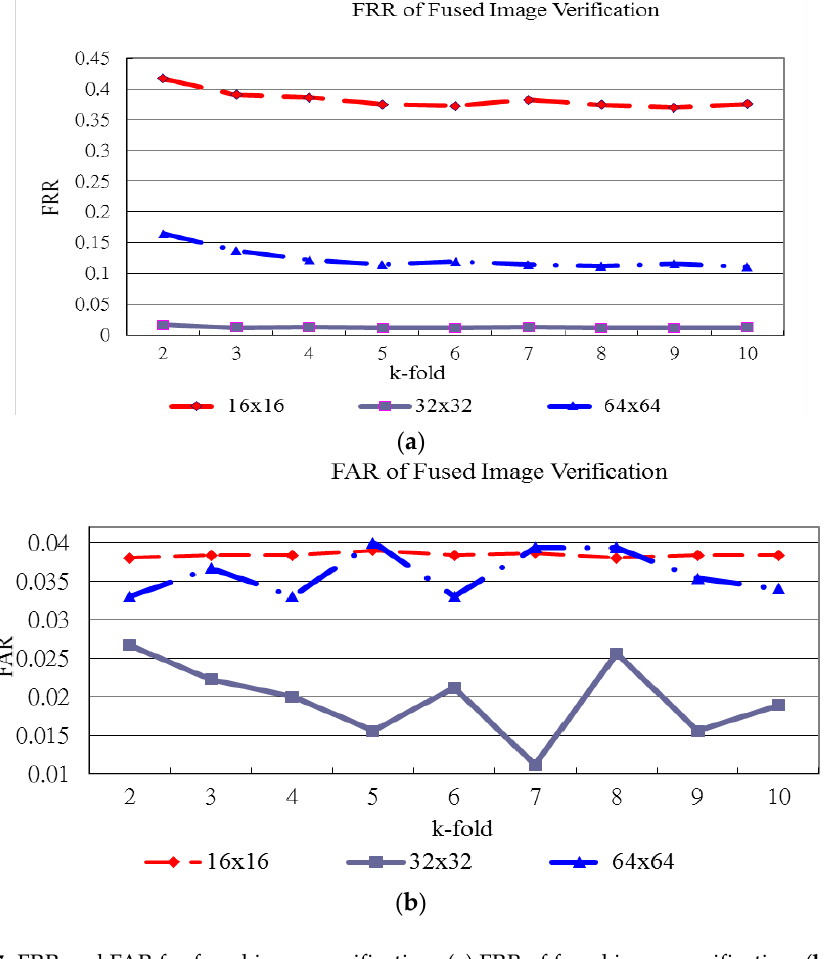
Figure 17. FRR and FAR for fused image verification. ( a ) FRR of fused image verification; ( b ) FAR of fused image verification.